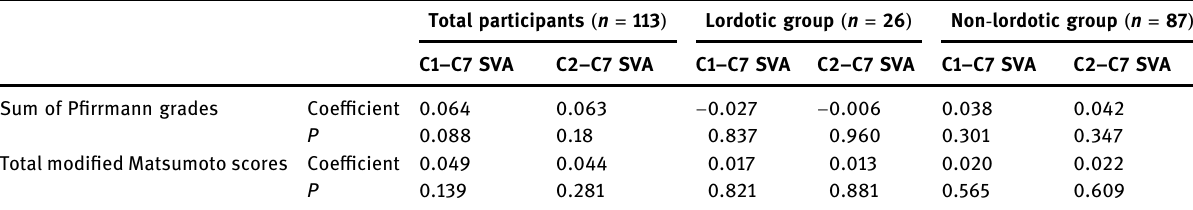
Table 4: Correlation between sagittal cervical vertical axis and degree of cervical disc